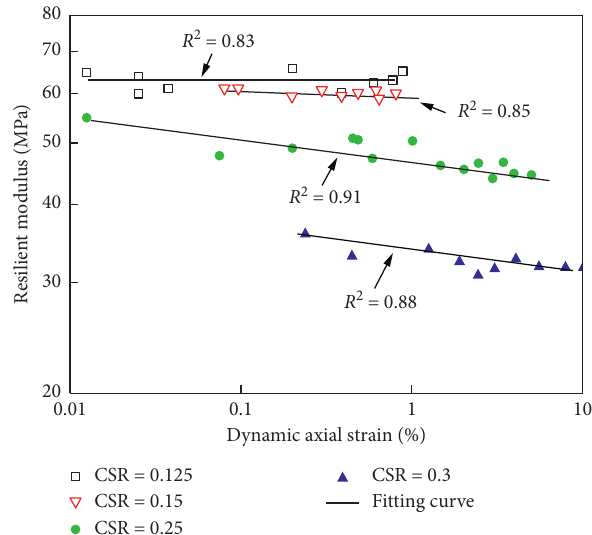
Figure 9: Variations of lg ( M R ) with lg ( ε d ) under different CSR.